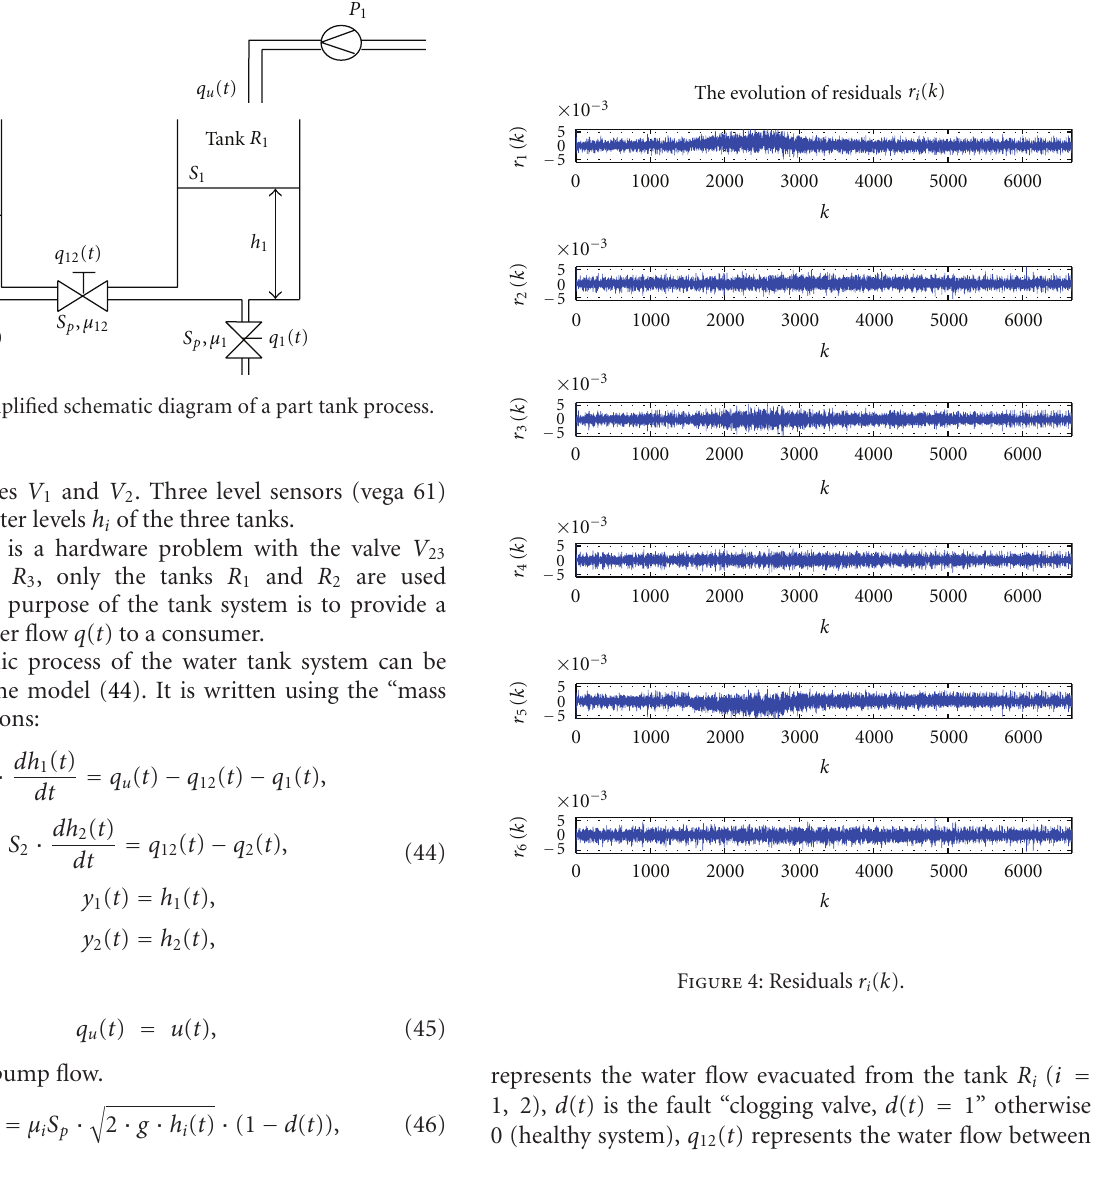
Figure 1: Tank system.